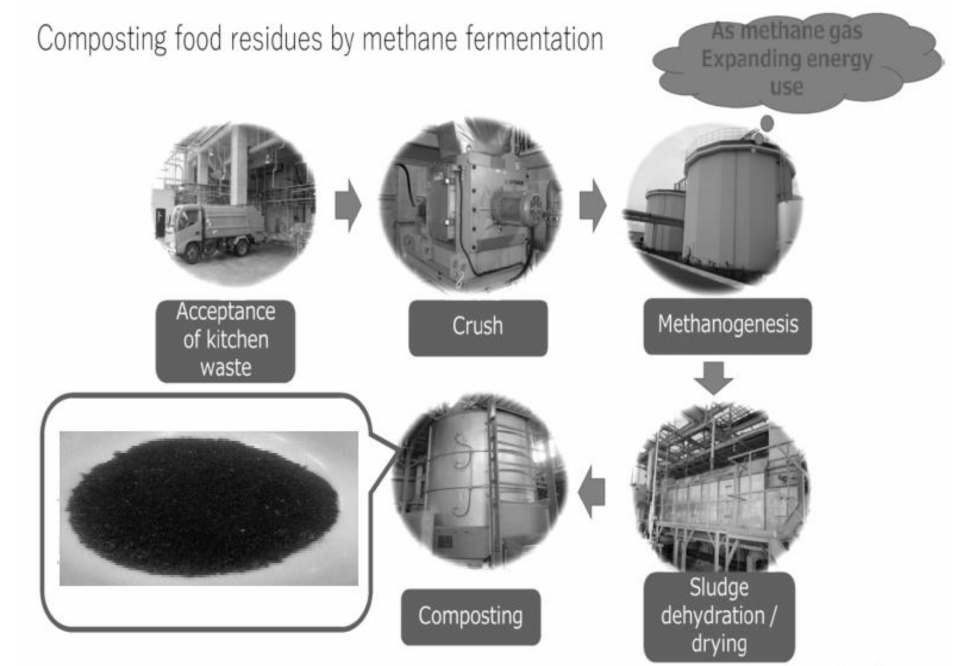
Figure 1. The production process of methane fermentation residues compost and biogas from local residence garbage. Methane fermentation residue component: total nitrogen 5.7%, phosphorus 2.2%, and total amount of potash 0.6% (Quoted from Hitachi Cement HP, 2016).